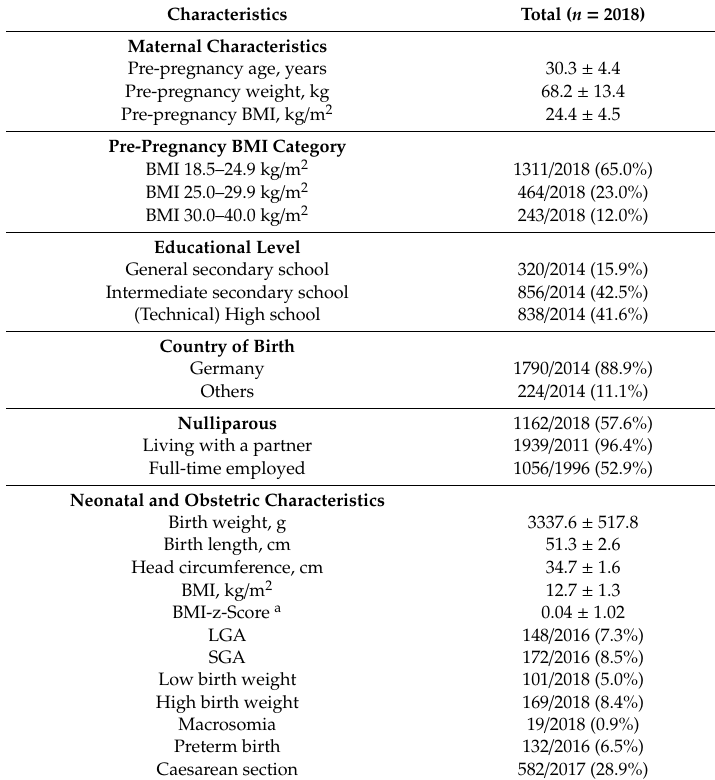
Table 1. Maternal, neonatal, and obstetric characteristics of eligible participants.